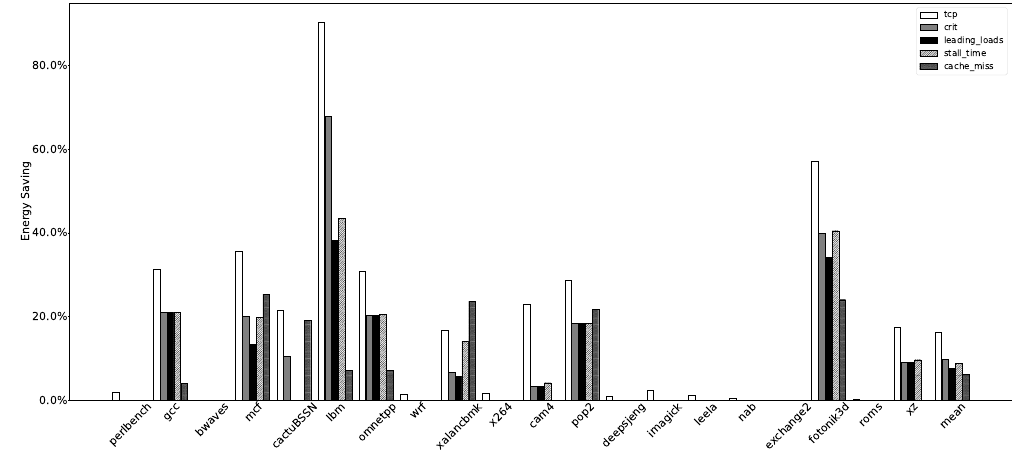
Figure 7. Comparison of energy consumption of power management